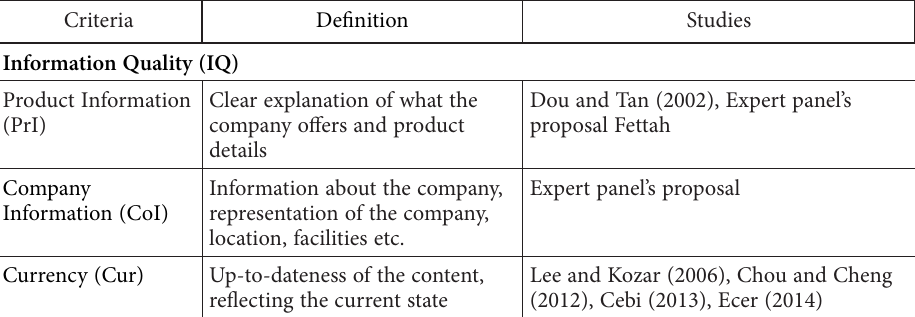
Table 1. The criteria and sub-criteria of website effectiveness